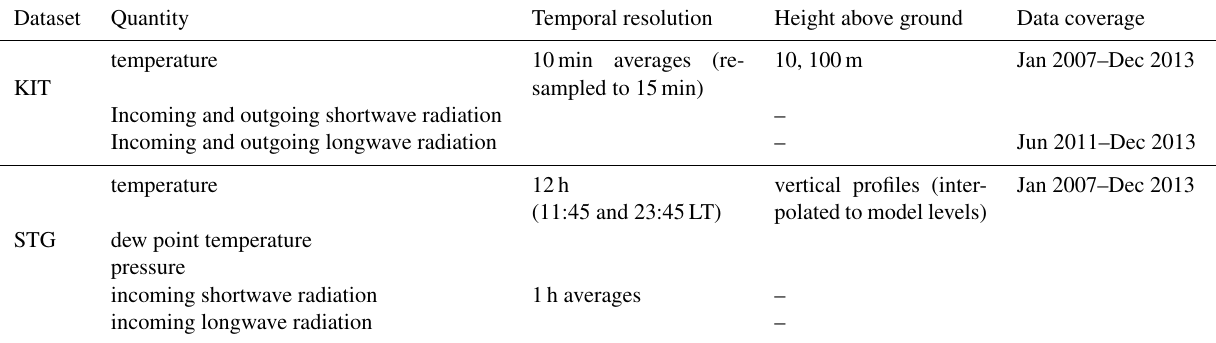
Table A2. Observed atmospheric variables at KIT and STG. Local time at STG is UTC + 1.